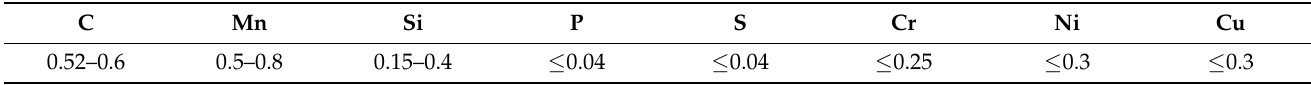
Table 2. Chemical composition of the material C55 (%).